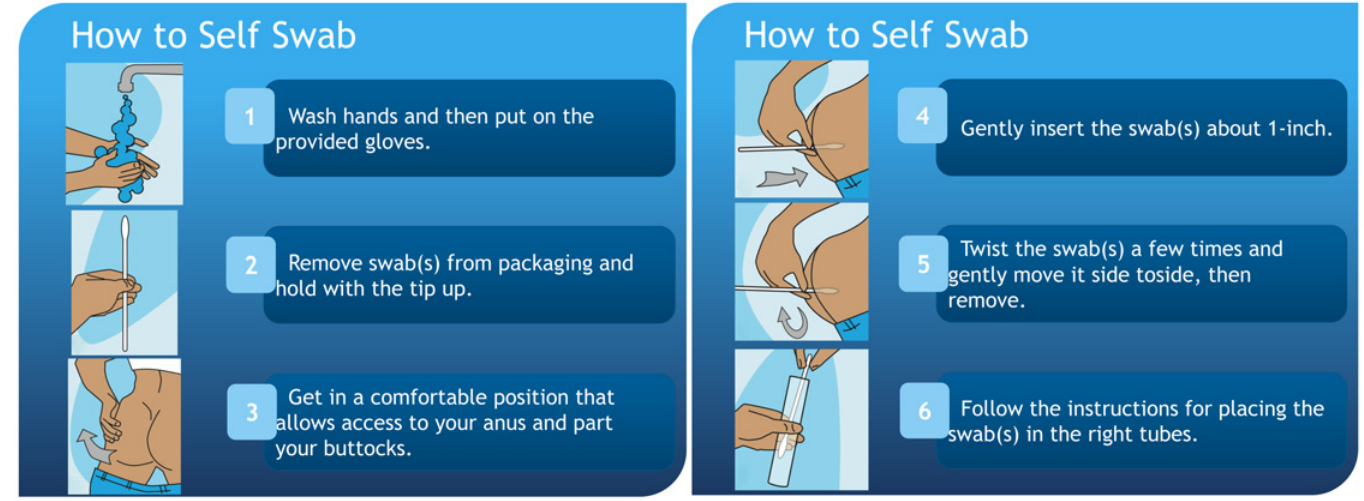
Fig 2. Instructions, with Illustrations, for the Self-Collected Rectal Swab for Gonorrhea and Chlamydia Testing (Aptima CA2, Hologic, San Diego, California). The MARI